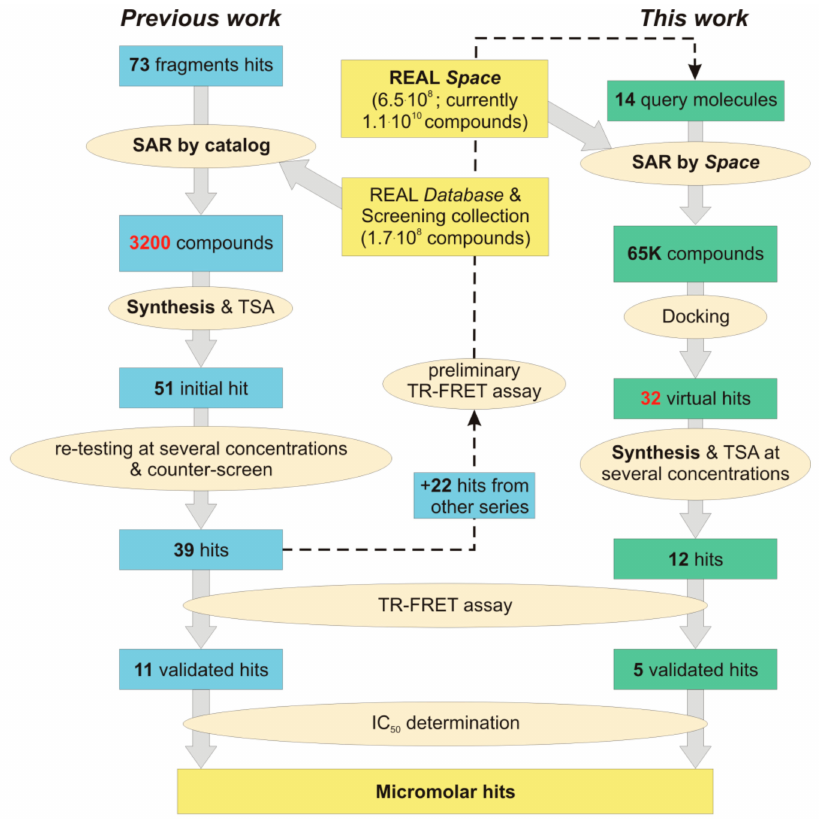
Figure 8. The workflow of the project described in this work compared to the fragment hit expansion used in our previous publication